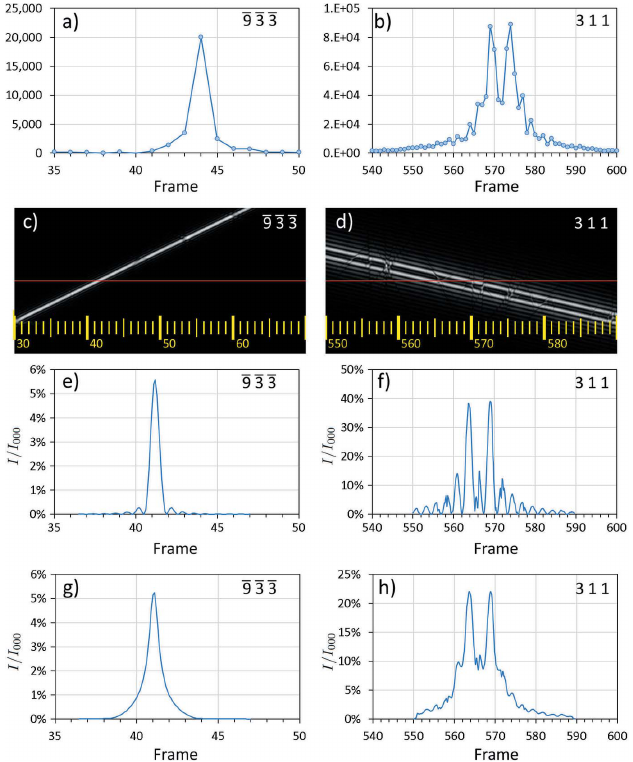
Figure 6 Two examples of silicon cRED rocking curves. ( a ) and ( b ) are experimental data. Most experimental rocking curves have a simple peak like ( a ) 933, while less than 3% show dynamical structure like ( b ) 311. ( c ) and ( d ) The corresponding dark-field LACBED simulations (specimen thickness 185 nm). The nominal beam path is a red line, with frame numbers in yellow. Intensity profiles along the red line give the rocking curves ( e ) and ( f ). The difference in frame numbers ( a ) to ( e ) and ( b ) to ( f ) is caused by a varying slew rate [Fig. 9( b )]. ( g ) and ( h ) Applying the angular spread of the incident beam (Fig. 10) as a convolution to the simulation gives simulated rocking curves that are a good match to experiment.